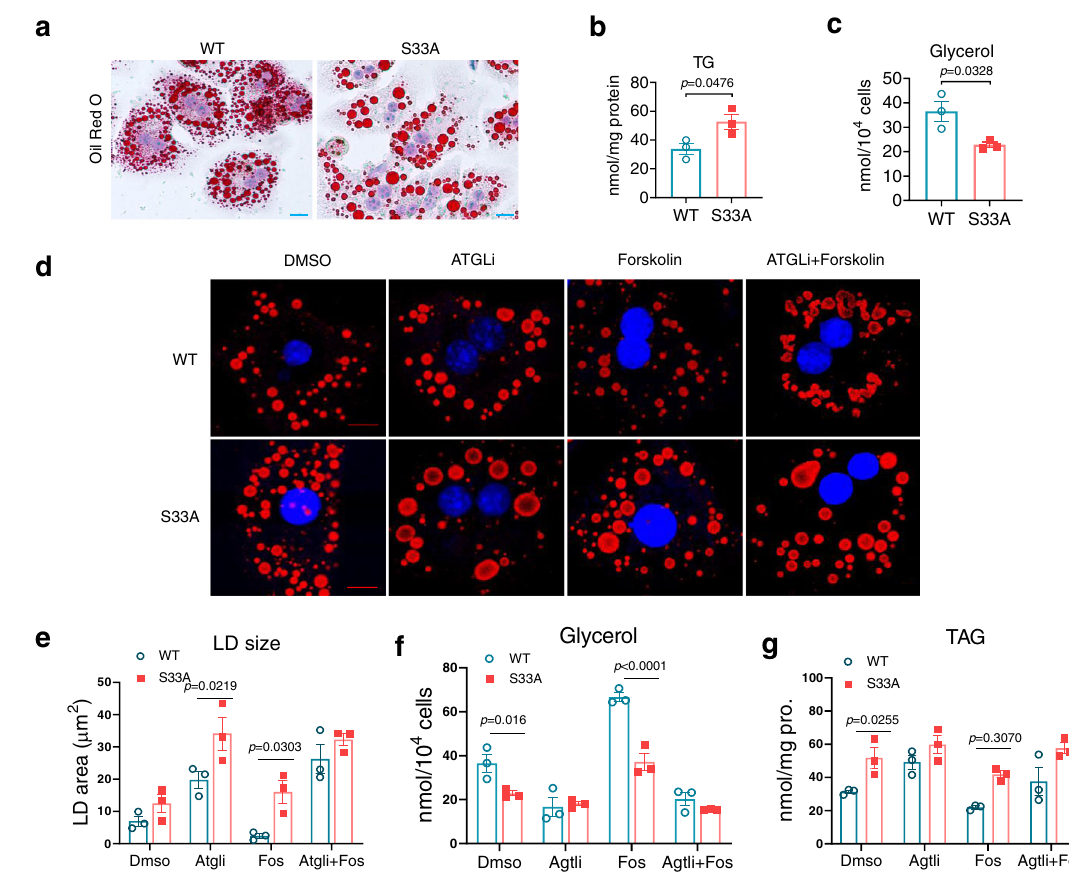
Fig. 7 | Primary hepatocytes of the Hsd17b13 33A/A mice are resistant to lipolysis viareducingATGLfunction.a Primaryhepatocytesfromthe Hsd17b13 +/+ (WT)and Hsd17b13 33A/A (S33A)micewereisolatedandstainedforLDswithOilRedO.Atbasal condition, the hepatocytes of the S33A mice exhibit larger LD size than that in the WT mice. Triglyceride contents ( b ) were higher, while the glycerol levels ( c ) were lowerin culturemedium of primary hepatocytes isolated from the S33Amice. WT: n = 3; S33A: n =3 biologically independent cells. d Confocal micrographs showing theLDs(red)andnuclei(blue)inprimaryhepatocytesisolatedfromtwogenotypes treated with atglistatin, an ATGL inhibitor (ATGLi, 10 μ M) and/or forskolin (10 μ M)